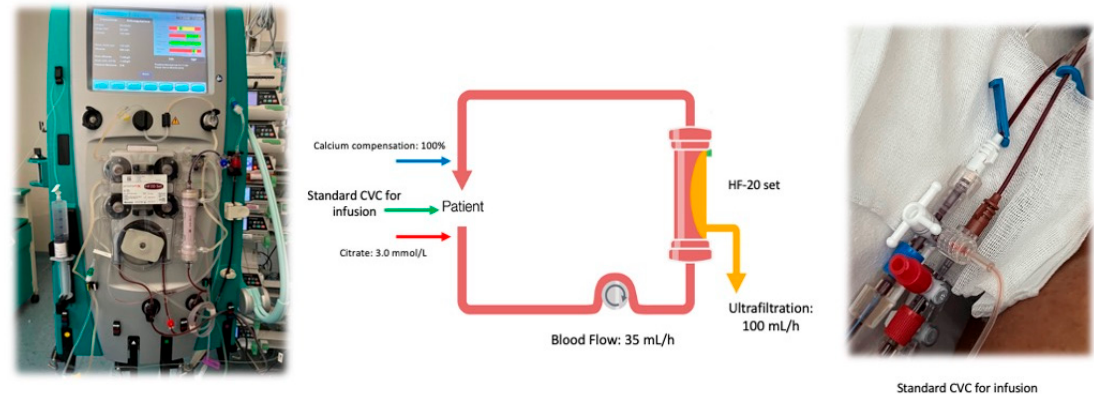
Figure 1. The 14 G lumen of the CVC was used as arterial line, and the 16 G lumen as venous line.